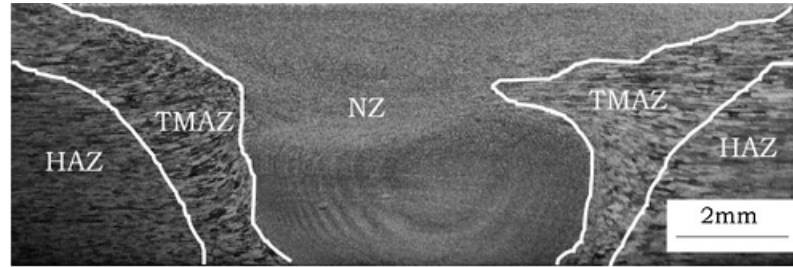
Figure 6. Metallographic morphology of the joint.